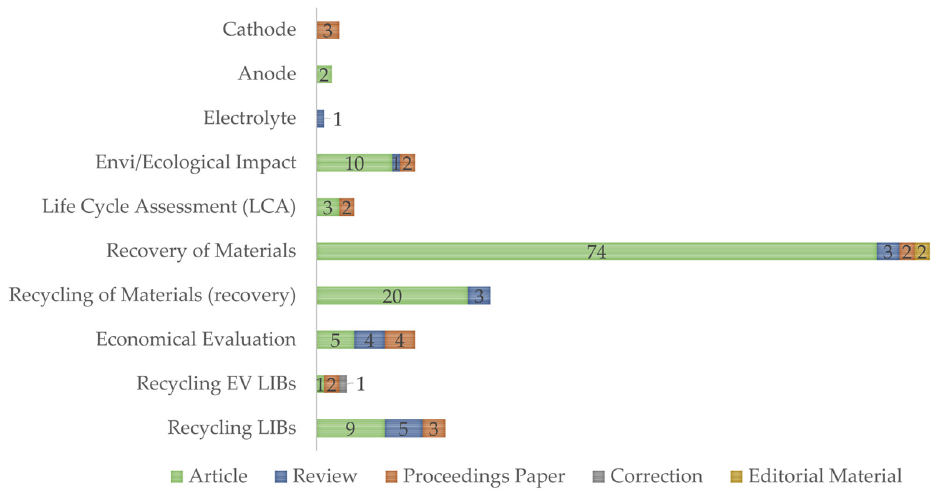
Figure 1. Distribution of reviewed publications according to their type.